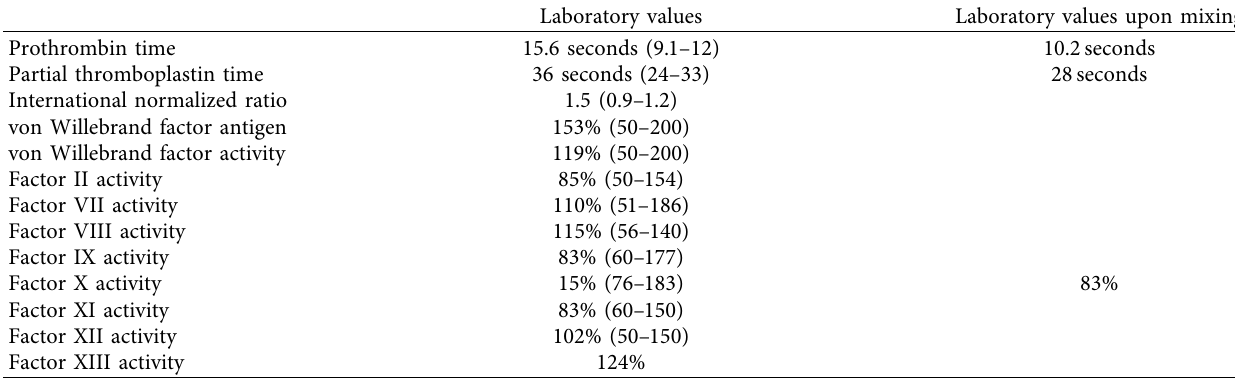
Table 1: Coagulation factors, prothrombin time, and partial thromboplastin time activities before and upon mixing studies. Laboratory